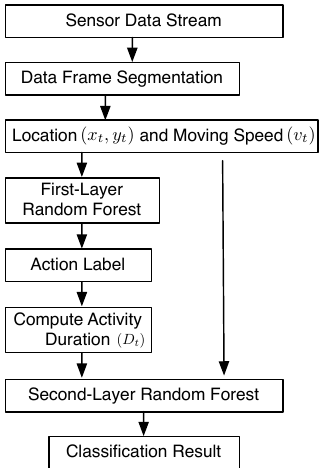
Figure 11. The overview of data processing. The feature vector for the first-layer RF is { x t , y t , v t } . The feature vector for the second-layer RF is { x t , y t , v t , D t } , where ( x t , y t ) is the location of the human target at the t th data frame, v t is the moving speed, and D t is the activity duration